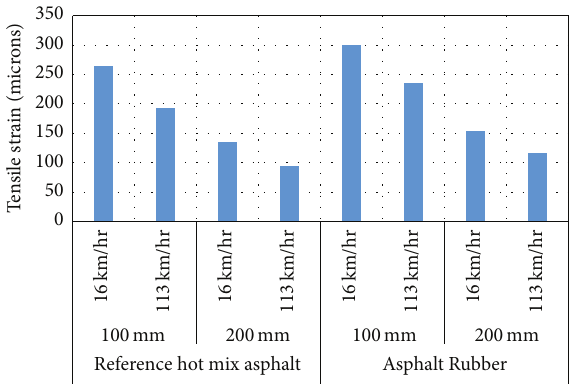
Figure 3: Tensile strains at the bottom of the HMA and AR layers for both pavement structures and two vehicle